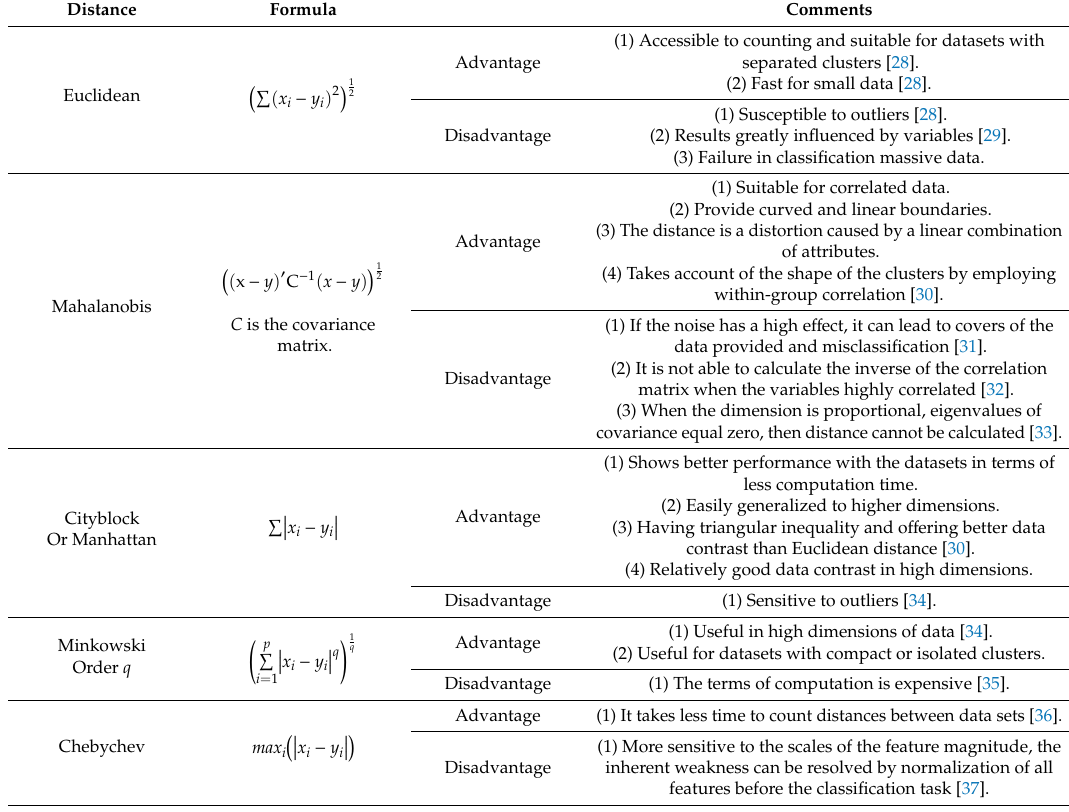
Table 6. Advantages and disadvantages of di ff erent uses distance. x and y are features vectors. Distance